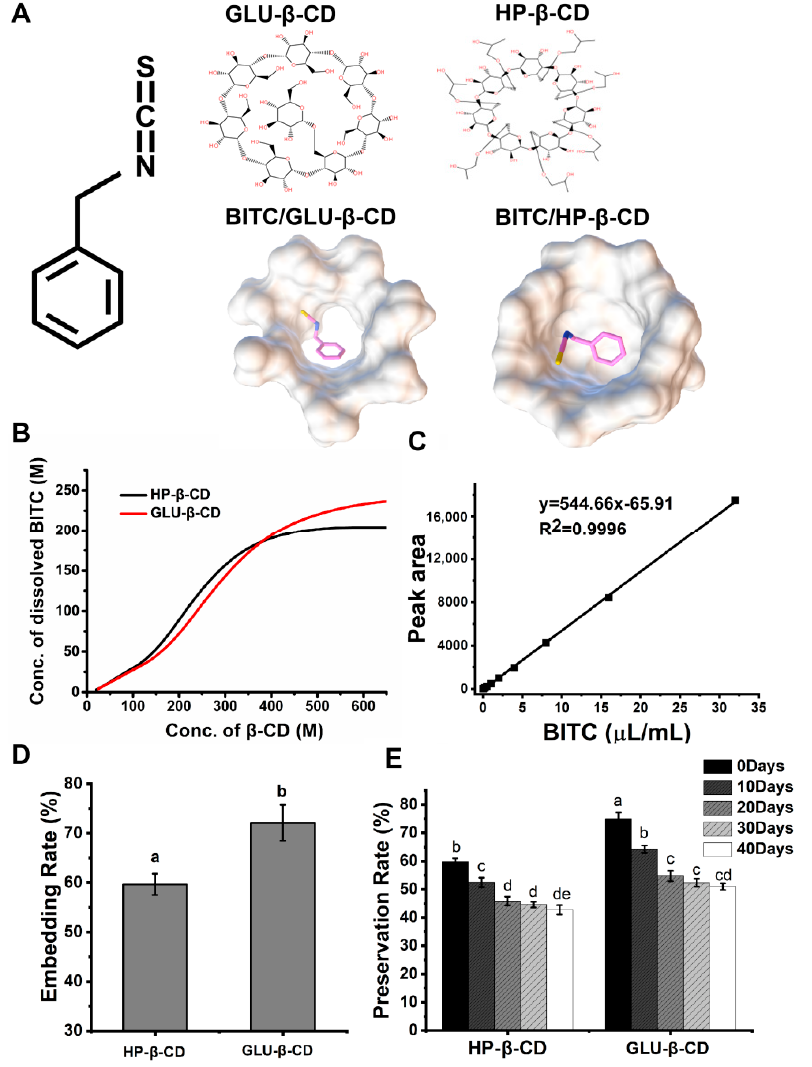
Figure 1. ( A ) Molecular simulated conformation of BITC- β -CD complexes. ( B ) Dissolved phase of BITC in the β -CD derivatives. ( C ) Standard curve of BITC. ( D ) Embedding rate of BITC in β - CD derivatives. ( E ) Stabilization of β -CD derivatives with BITC. Letters a-e represent statistically significant values at p ≤